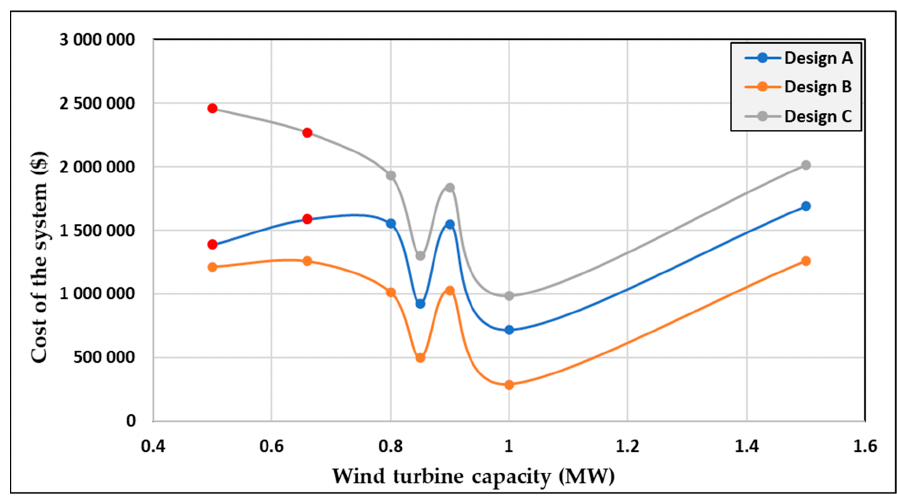
Figure 8. Comparison of grid connected system for design A, B, and C.